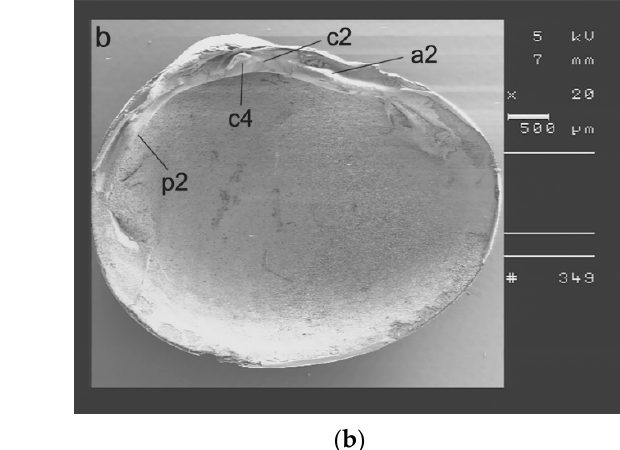
Figure 5. Morphometrics analyses of valves of P. casertanum . ( a ) Insight view of right valve with cardinal tooth c3, anterior lateral teeth a1 and a3, posterior lateral teeth p1 and p3. ( b ) Insight view of left valve with cardinal teeth c2 and c4, anterior lateral tooth a2, posterior lateral tooth p2.